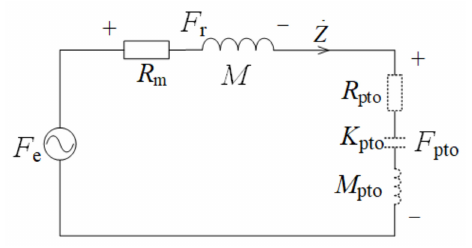
Figure 4. The equivalent circuit